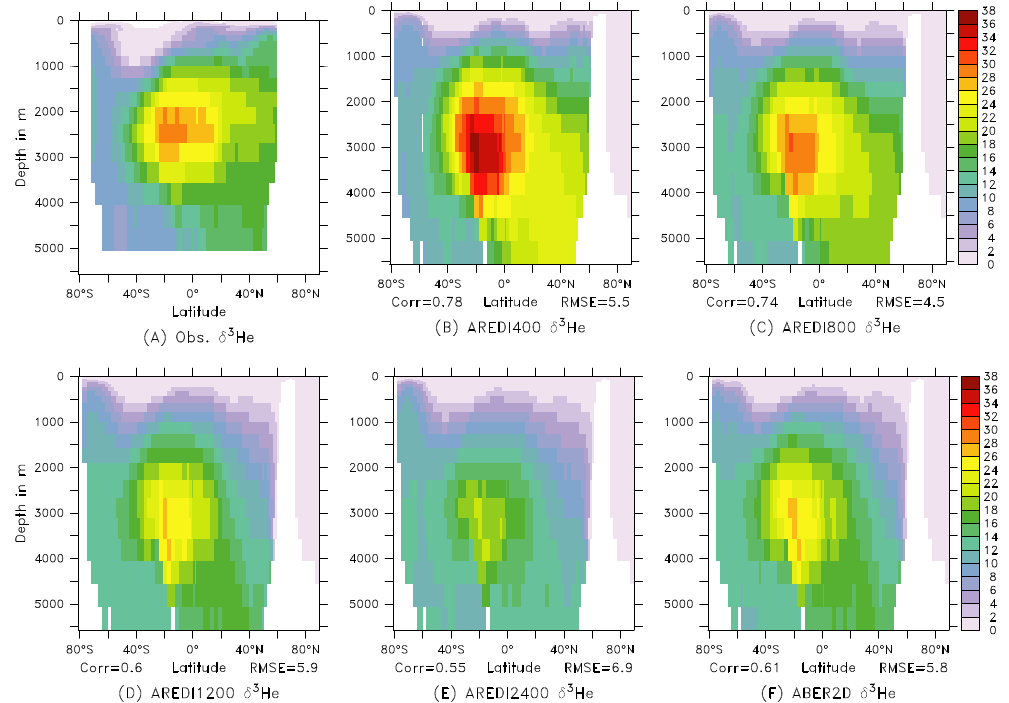
Figure 6. Zonally averaged δ 3 He in (%) in the Pacific. (a) From the observational data set of Bianchi et al. (2010). (b) AREDI400. (c) AREDI800 (d) AREDI1200 (e) AREDI2400 (f)